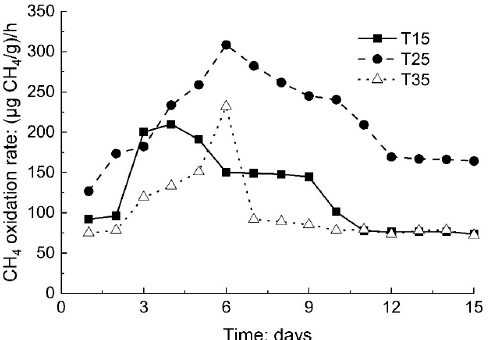
Figure 6. Methane oxidation rate of cover soil under different temperatures versus time.